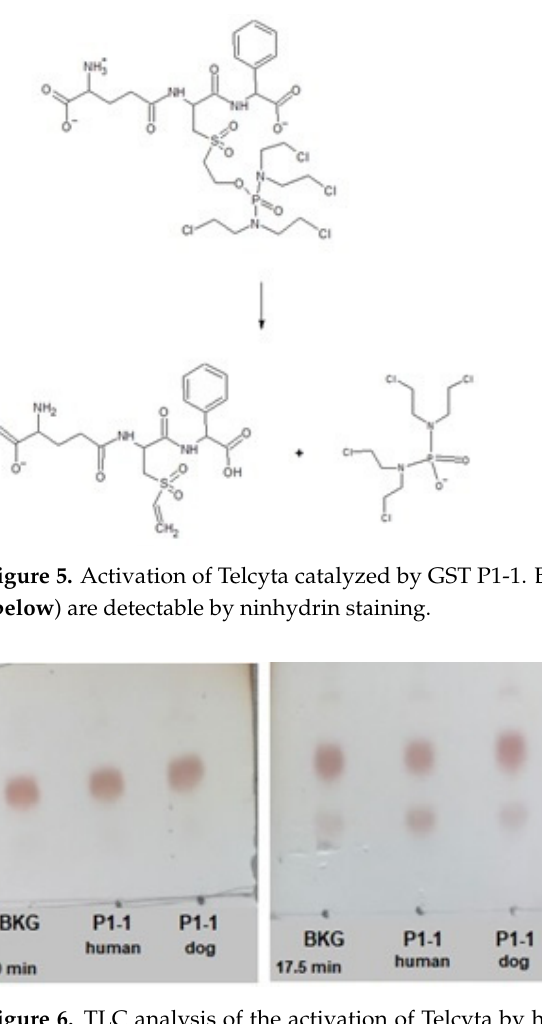
Figure 6. TLC analysis of the activation of Telcyta by human and dog GST P1-1. Aliquots of the reaction mixture were taken at a series of different time points. The left panel shows Telcyta at time zero and the right panel shows the emergence of the peptide product below after 17.5 min. Reactants were developed by ninhydrin staining and quantified; the nonenzymatic contribution (BKG) was subtracted from the reaction in the presence of 0.25 µg enzyme.